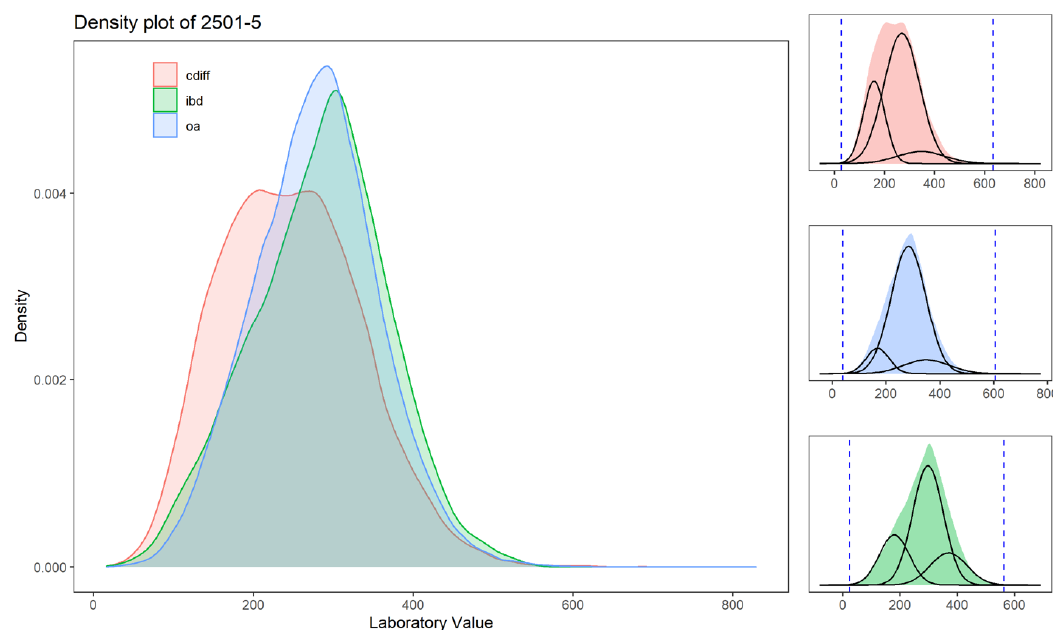
Figure 2. Distribution of laboratory values normalized for Logical Observation Identifiers Names and Codes (LOINC) 2501-5 (iron-binding capacity) for the three datasets (Cdiff in red, IBD in green, and OA in blue). The “iron-binding capacity” is missing at 52% in the Cdiff dataset, 65% in the IBD dataset, and 64% in the OA dataset. The subpanels represent the three modeled distributions to calculate the upper and lower boundaries. The dashed lines represent the upper and lower outlier boundaries (based on Equation (1)).